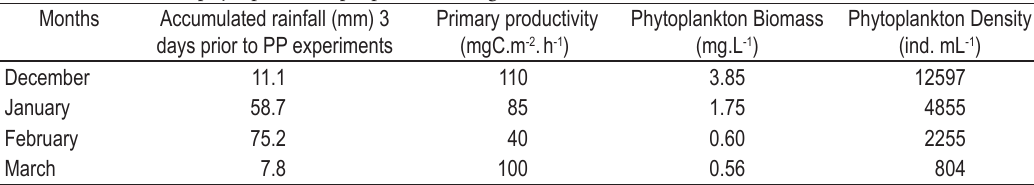
Table 3. Rainfall and phytoplankton properties during the summer of 1999.